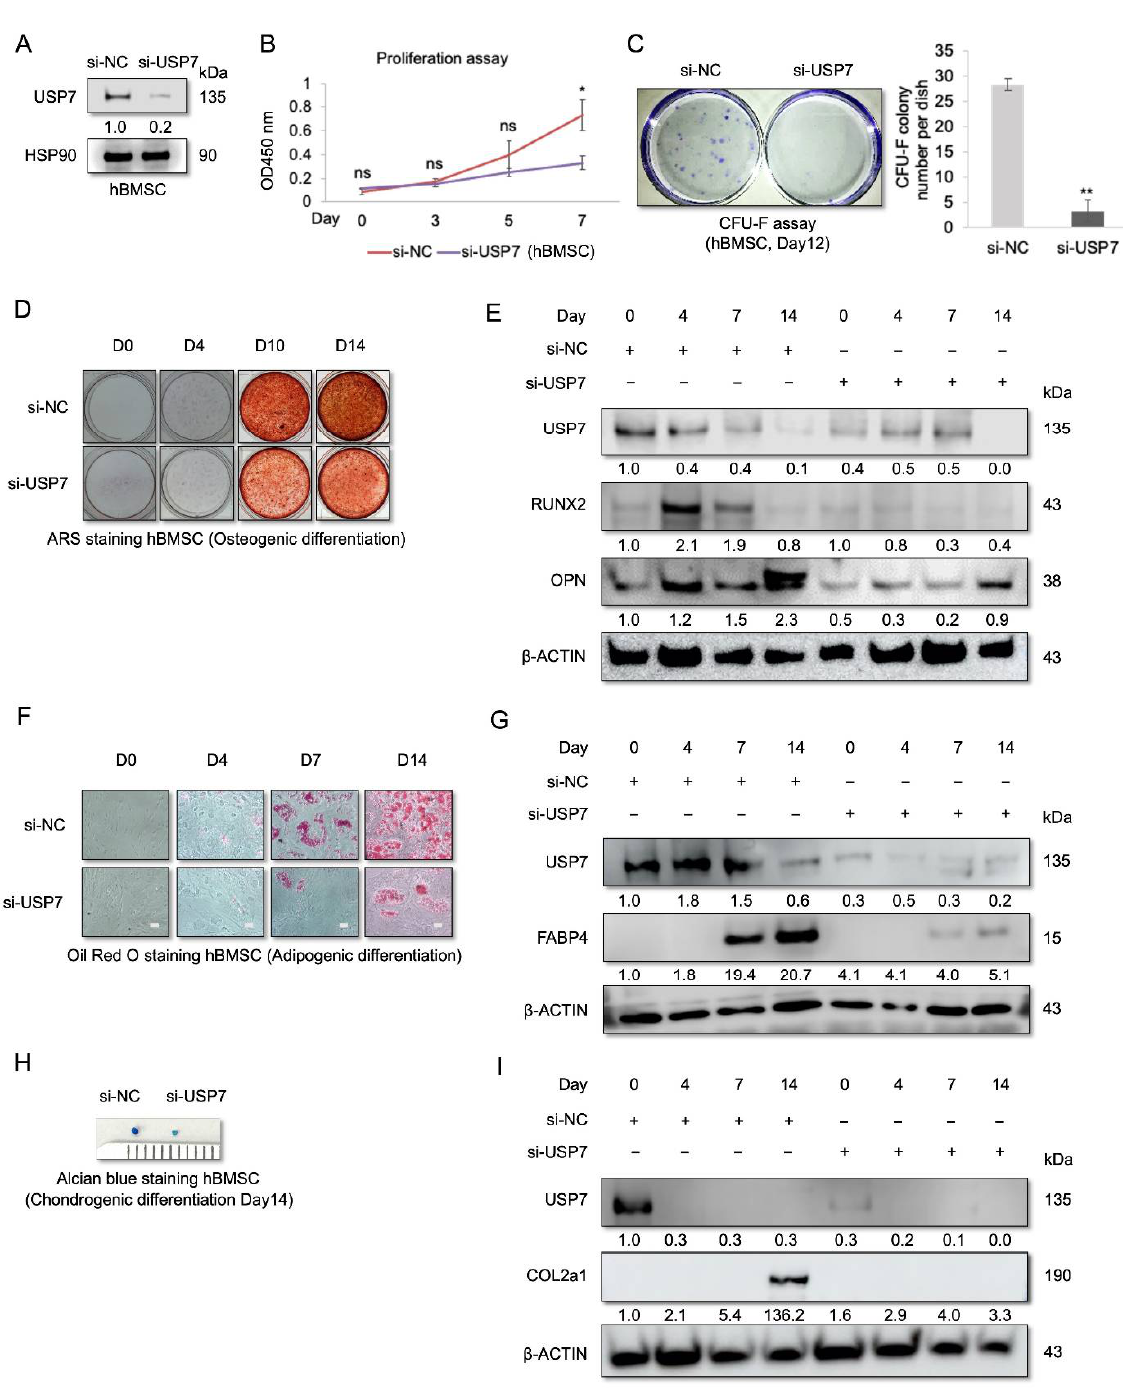
Figure 2. Effect of USP7 knockdown on the self-renewal and differentiation of early passage hBMSCs. ( A ) Immunoblot analysis of hBMSCs following transfection with the negative control or USP7 siRNA. ( B ) Results of the cell proliferation assay. ( C ) Results of the colony-forming unit fibroblast (CFU- F) assay. On day 12 of the CFU-F assay, colonies were stained with crystal violet. ( D ) Results of the ARS staining. ( E ) Representative immunoblots depicting results of osteogenic differentiation. ( F ) Results of the Oil Red O staining. Scale bar = 200 µ m. ( G ) Representative immunoblots depicting results of adipogenic differentiation. ( H ) Alcian blue staining results. ( I ) Representative immunoblots depicting results of chondrogenic differentiation. Data are presented as mean ± SD. ns; not significant, * p < 0.05, ** p < 0.01. n =